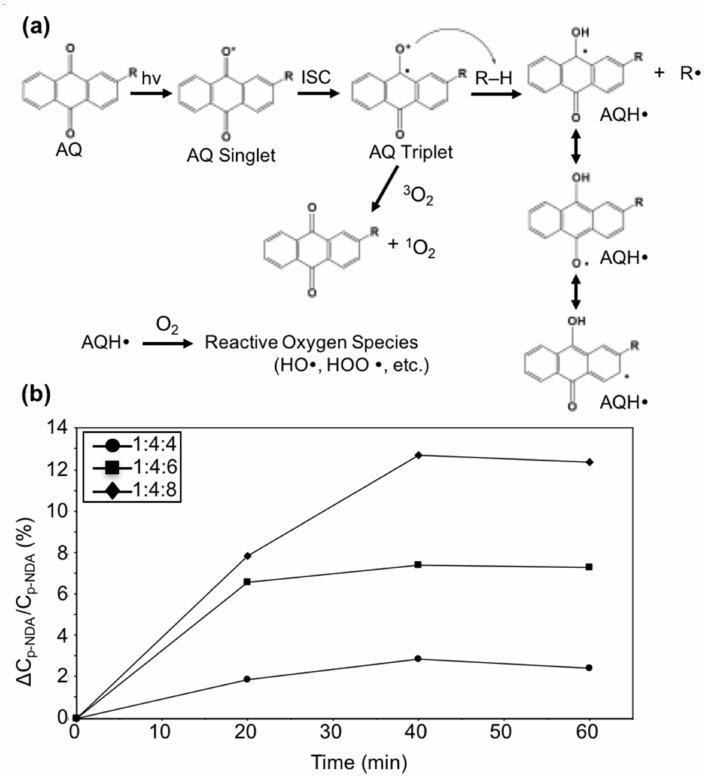
Figure 6. ( a ) Scheme of the photo-reaction of AQ derivatives with R–H (cellulose) and the formation of ROS. ( b ) Generation of hydroxyl radicals in darkness by AQ-CNCs from varied AQC / CDI molar